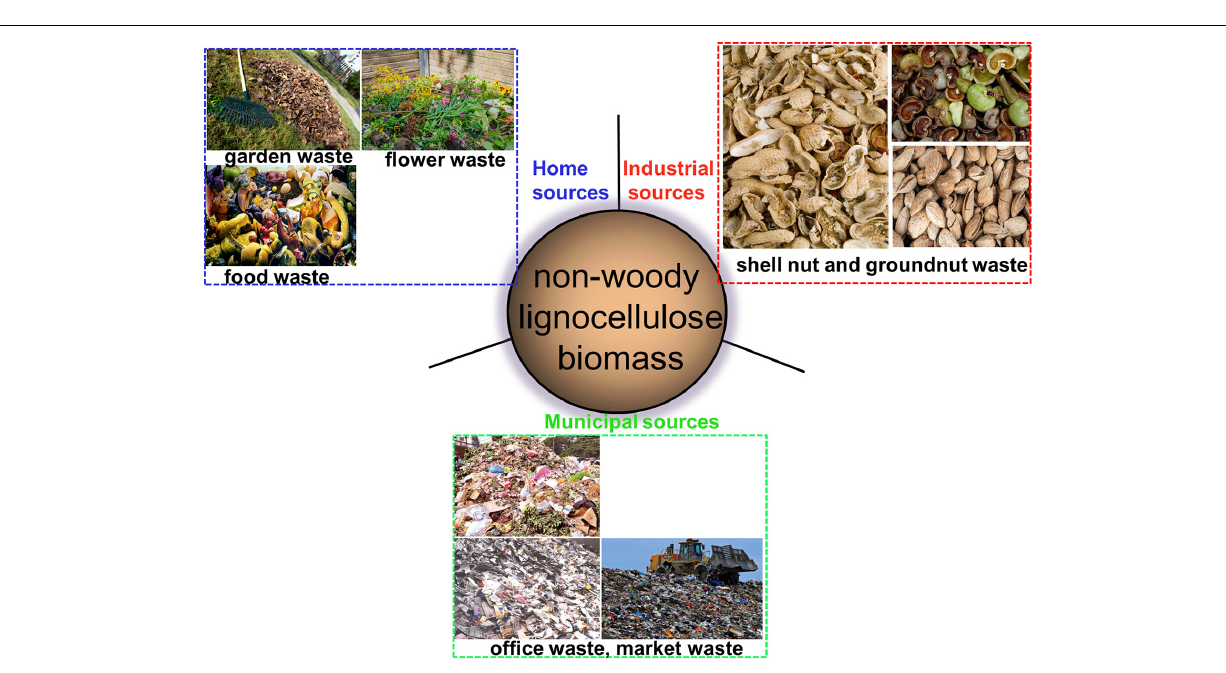
FIGURE 2 | Selected samples of non-woody lignocellulose biomass in our immediate